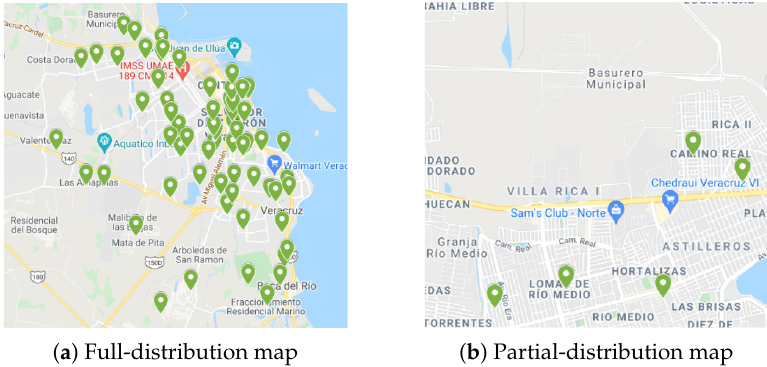
Figure 17. Distribution of deliveries in the city of Veracruz-Boca del